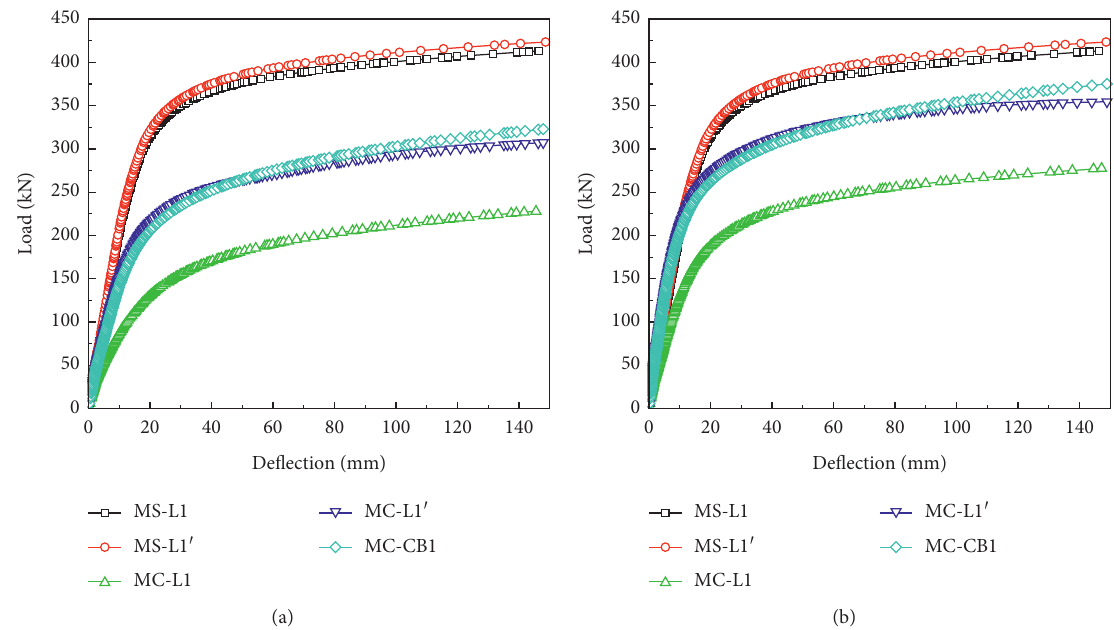
Figure 19: Load-deflection curves of the TGCB models with and without bottom lateral bracings: (a) outer girder G1; (b) inner girder